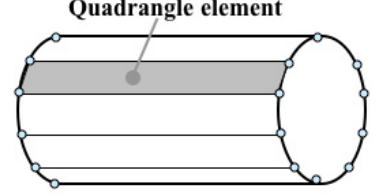
Fig. 13. Cooling-channel surface meshing.